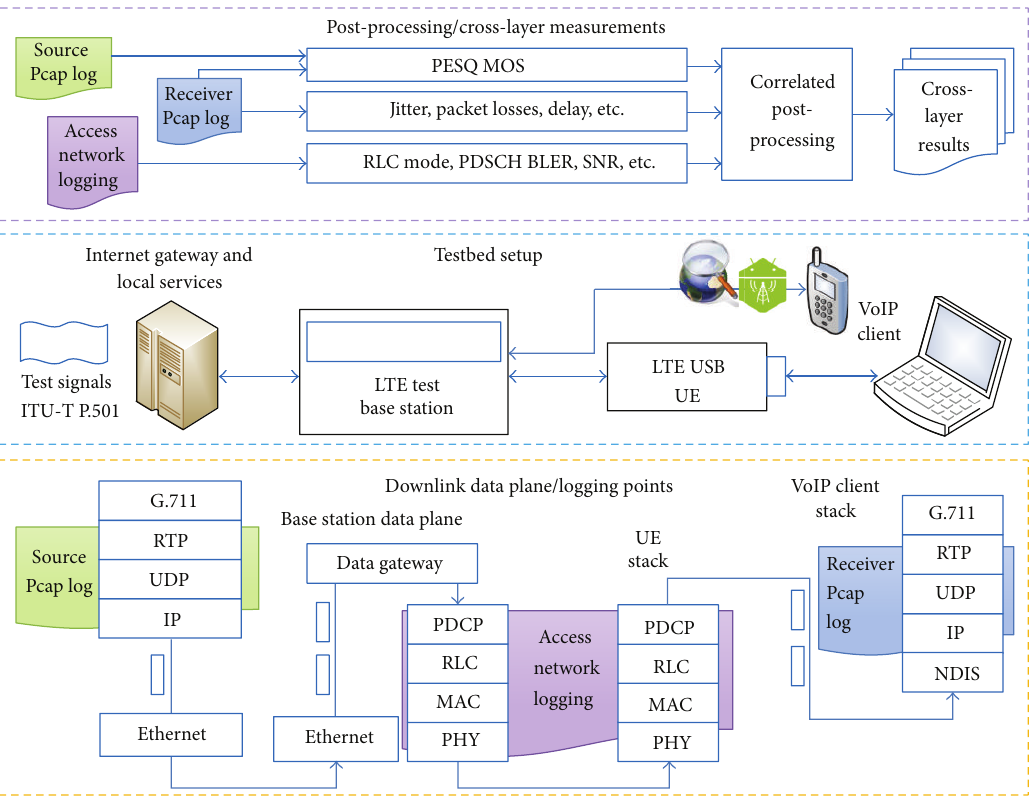
Figure 2: Testbed